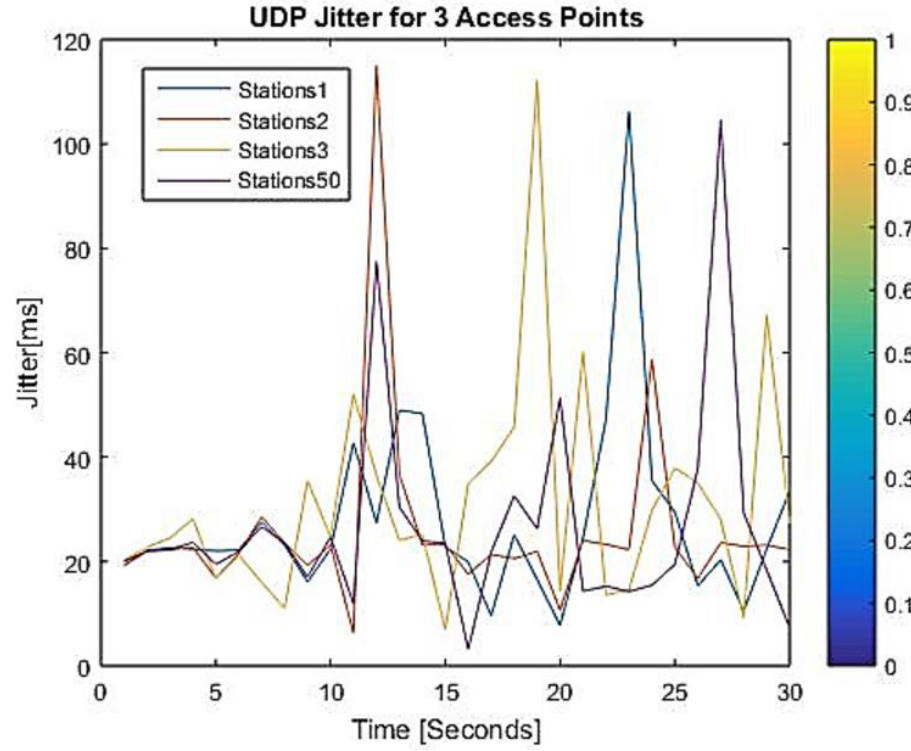
Figure 15. UDP jitter for 2 access points.